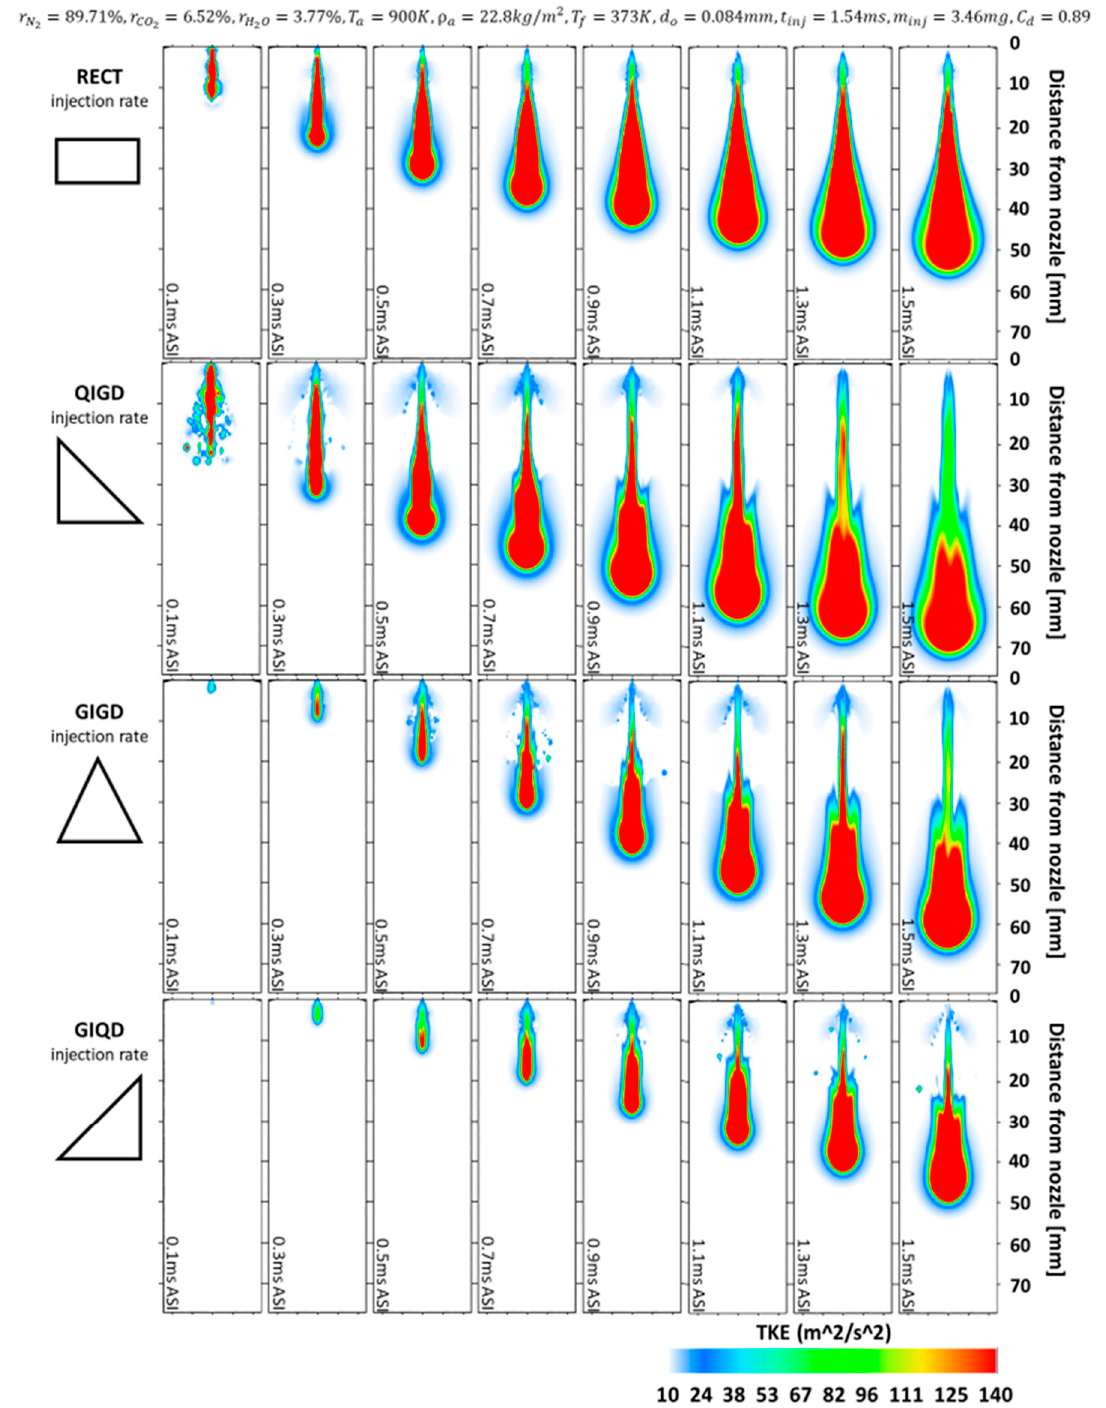
Figure 23. Comparison of the TKE distribution during injection for different injection rate shapes.